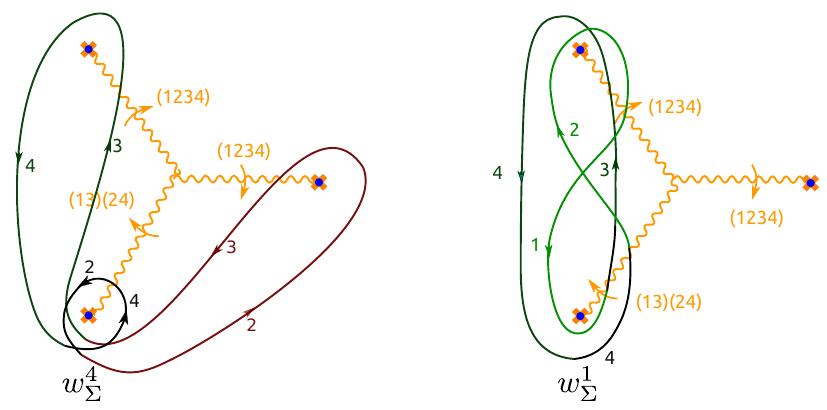
Figure 8 . Building closed cycles with charge (cid:13) 1 + (cid:13) 2 as combinations of lifts. Left: w 4 Right: w 1